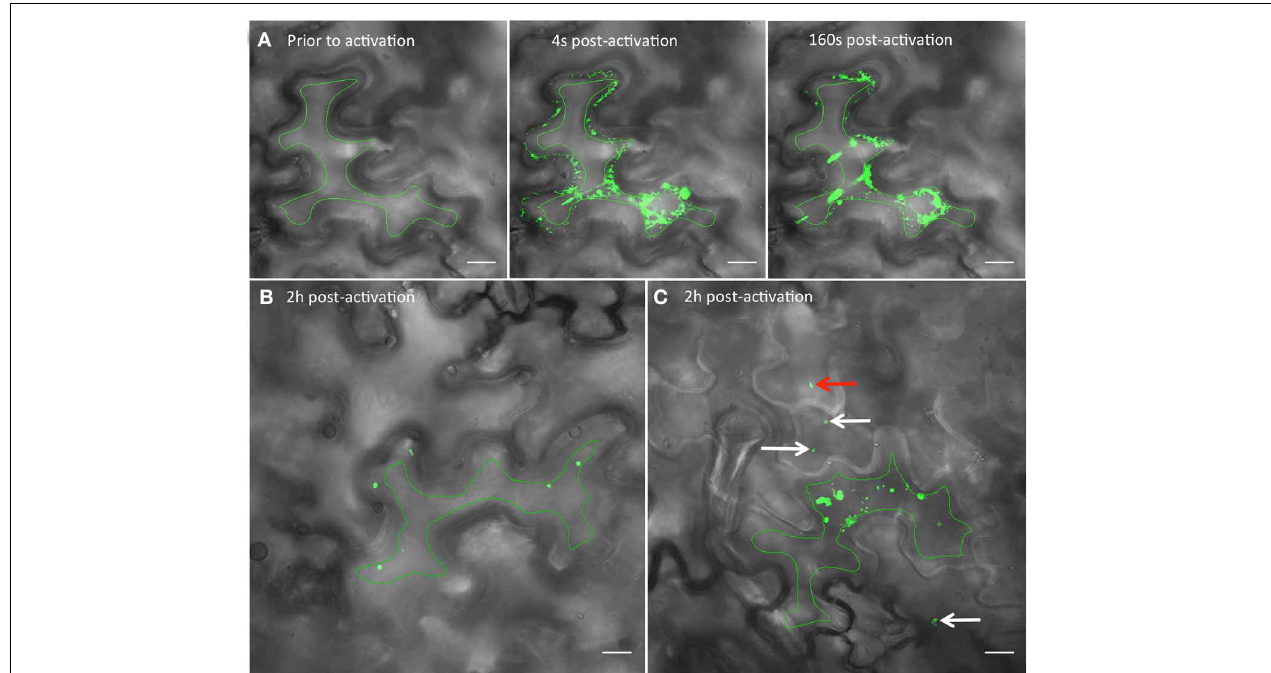
TuMV producing 6K 2 :mCherry-tagged vesicles and expressing 6K 2 :PAGFP 2h after photoactivation. The red channel is not represented. White arrows in (C) point to vesicles that have moved through one cell layer. Red arrow in (C) points to a vesicle that has moved through two cell layers. Green line in (A–C) indicates activation area. Scale bar = 20 µ